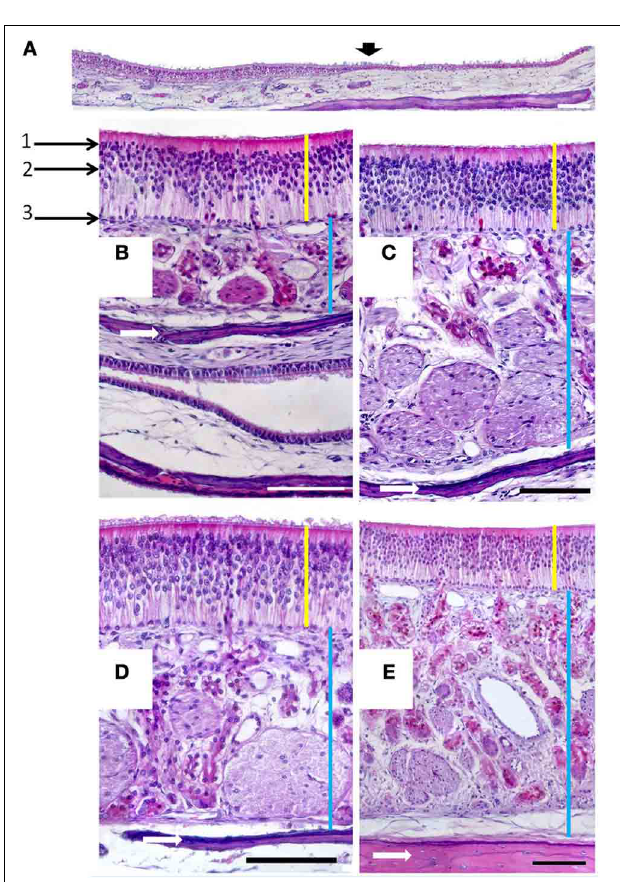
FIGURE 4 | (A) Hematoxylin-eosin-stained longitudinal section showing the transition (arrowed) from the respiratory to the sensory epithelium. (B–E) Hematoxylin-eosin stained transverse sections showing the mucosa of ectoturbinate 2 (B) , ectoturbinate 3 (C) , endoturbinate III (D) , and the nasal septum (E) . Yellow bars indicate sensory epithelium; blue bars, lamina propria; and white arrows, bone. 1, supporting cells; 2, neurons; 3, basal cells. Scale bars: (A) 2mm; (B–E) 100 μ m (see Figure